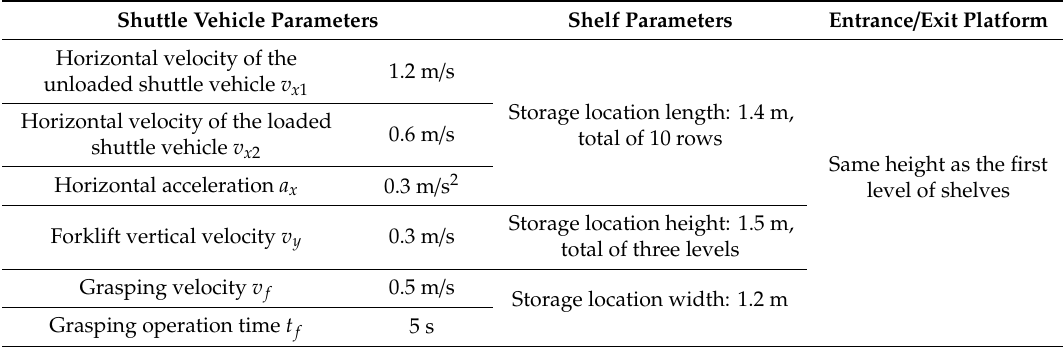
Table 1. Warehouse shelf